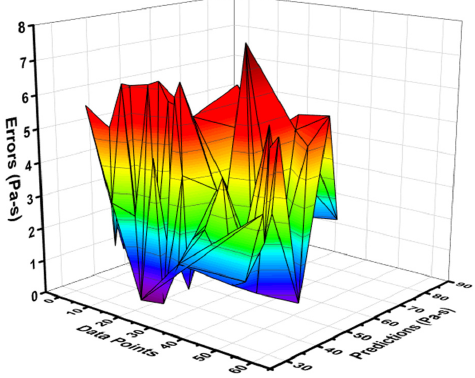
Figure 8. Error distribution of NN model for plastic viscosity.